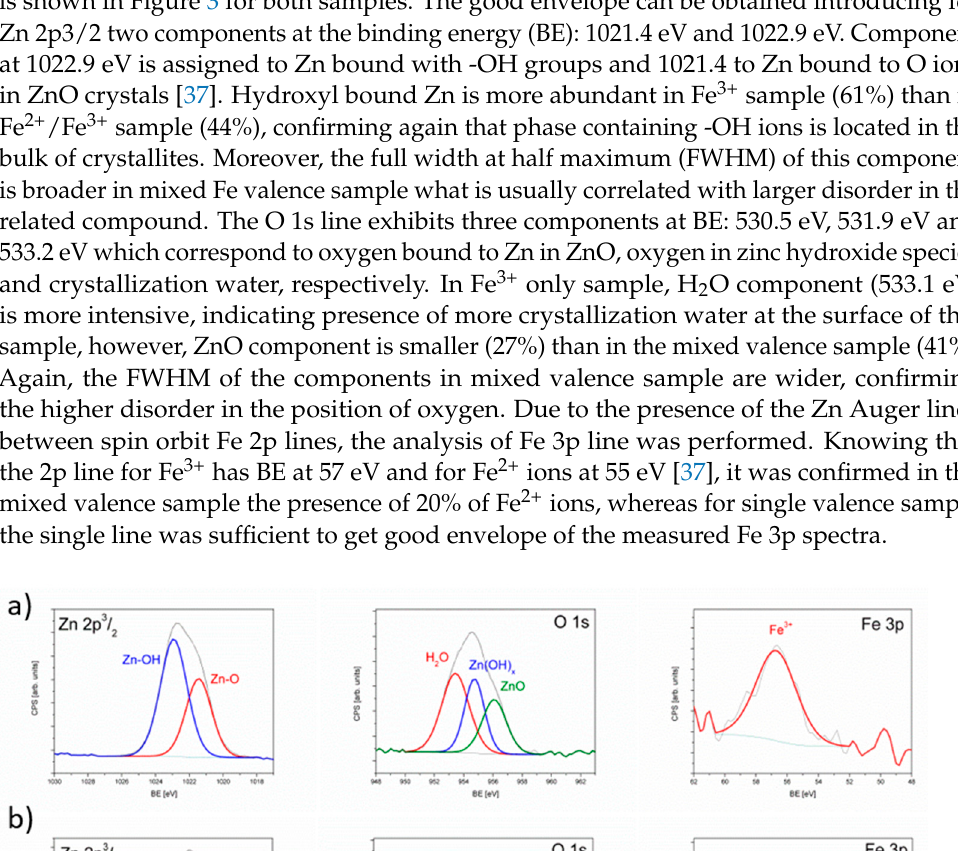
Table 2. X-ray photoelectron spectroscopy (XPS) measured elemental composition of ZnO:Fe 3+ and ZnO:Fe 3+,2+ samples. Concentrations given in atomic